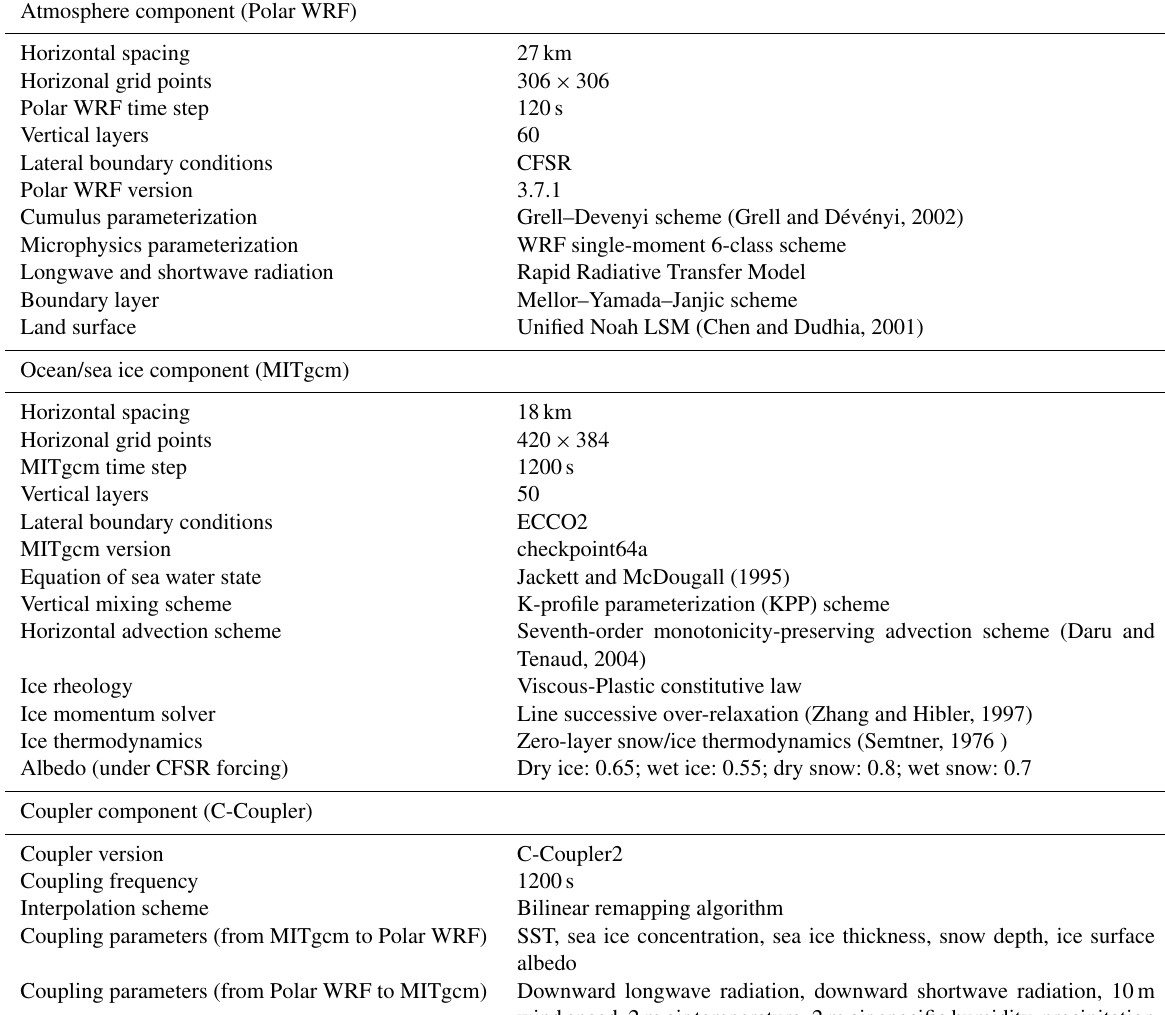
Table 1. The summary of physics option and details of coupled